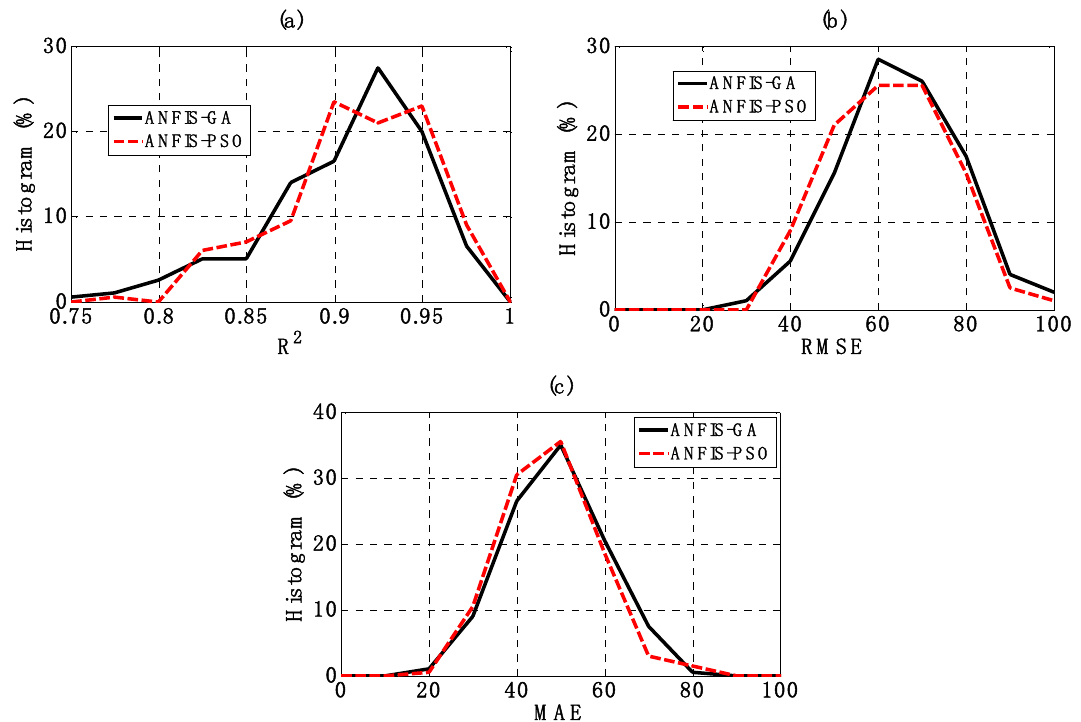
Figure 10. Graphs of the histogram of ( a ) R 2 , ( b ) RMSE and ( c ) MAE. Table 4. Summary information of robustness analysis.